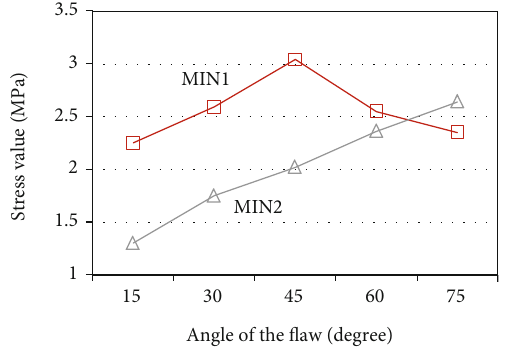
Figure 3: Evolution of the minimum principal stress.